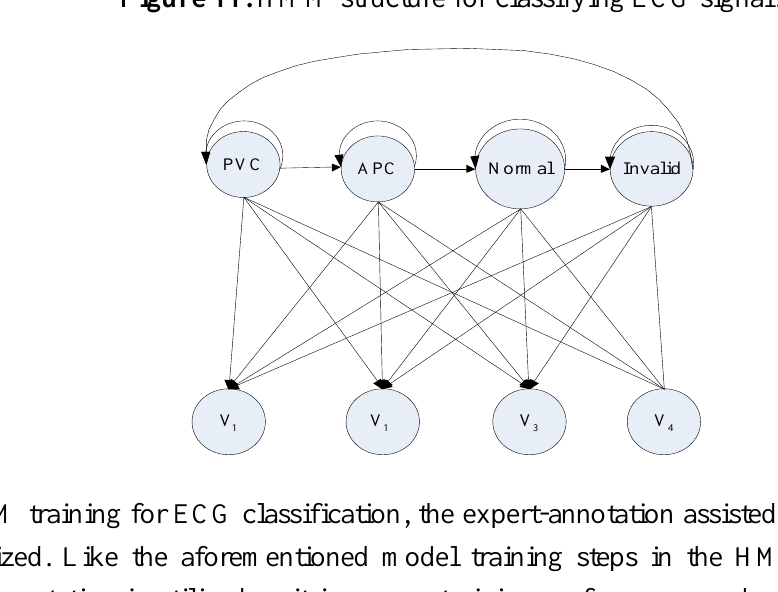
Figure 11. HMM structure for classifying ECG